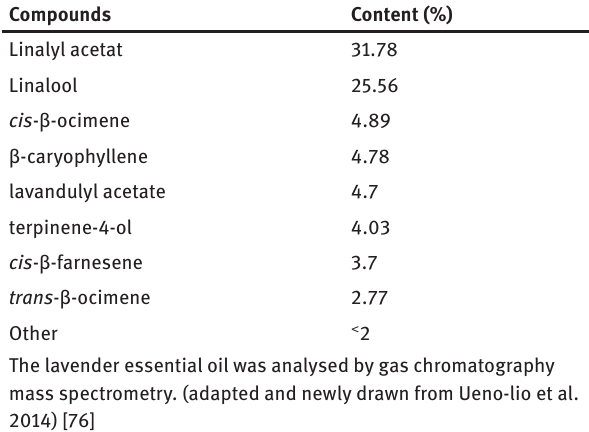
Table 5: Chemical composition of Lavandula angustifolia EO.